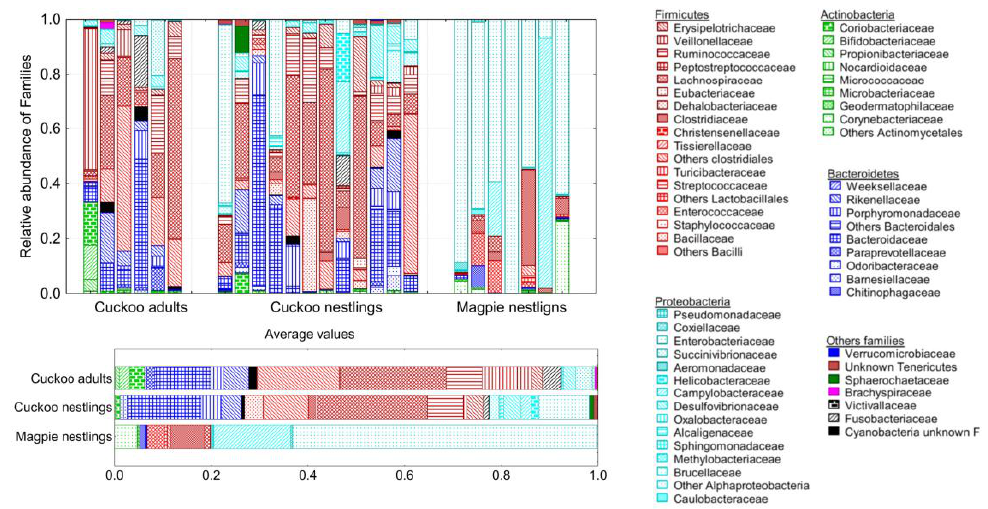
Figure 2. Differences in whole composition of the cloaca microbiota among cuckoo nestlings, magpie nestlings, and adult cuckoos. ( A ) Distances based on weighed unifrac β -diversity; ( B ) Distances based on unweighed unifrac β -diversity. Lines surround samples clustered by percentage of similarity (20% or 40%) among their whole microbial communities. PCO2: second principal coordinate axis; PCO1: first principal coordinate axis.